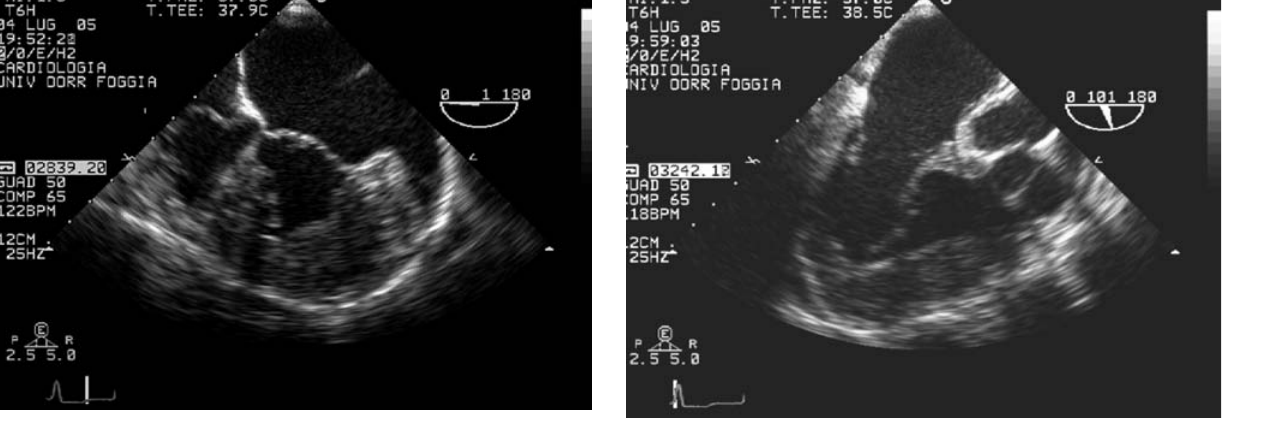
Figure 6 - In prominent systemic ventricle hypertrophy, the aortic valve and the systemic atrioventricular valve are discontinuous because of